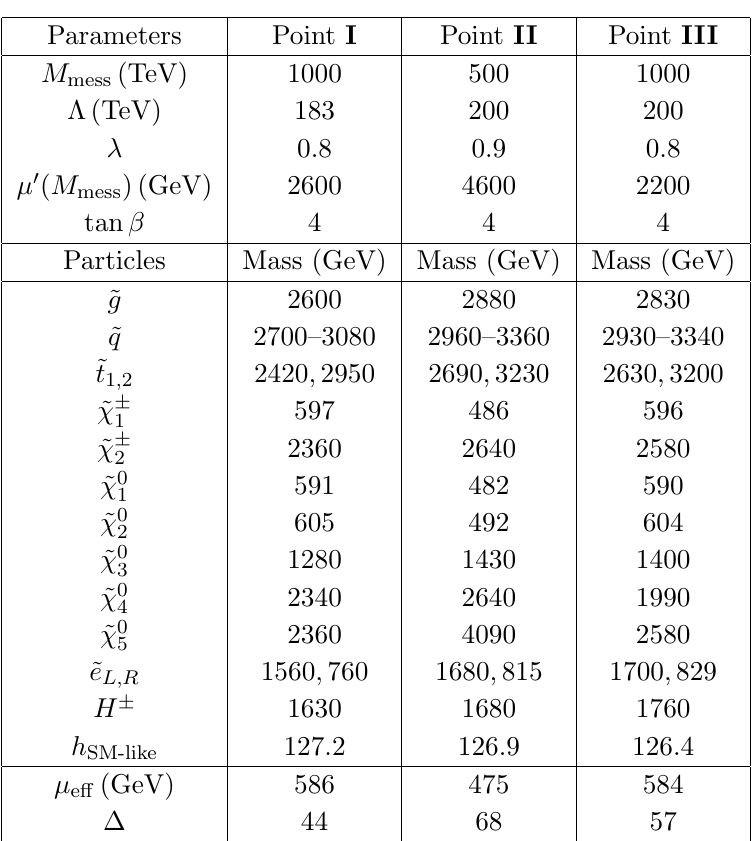
Figure 3 . The contours of (cid:1) (black solid) and m h (red dashed), where m h is shown in units of GeV. The parameters are same as in (cid:12)gure 2.